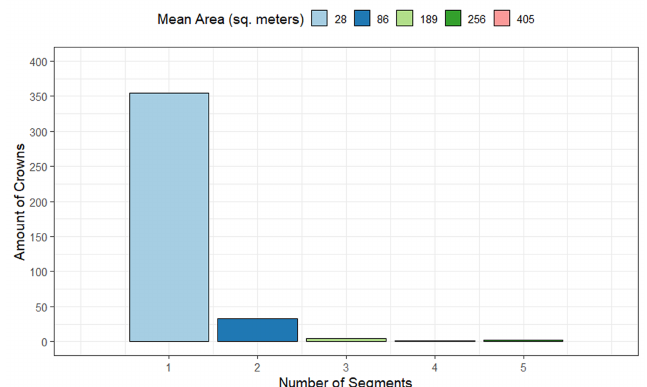
Figure 9. Number of tree canopies with segments intersecting them. The legend brings the mean crown area, in square meters, for each group. For example: the mean crown area for tree crowns intersected by 1 segment is 28 m 2 .